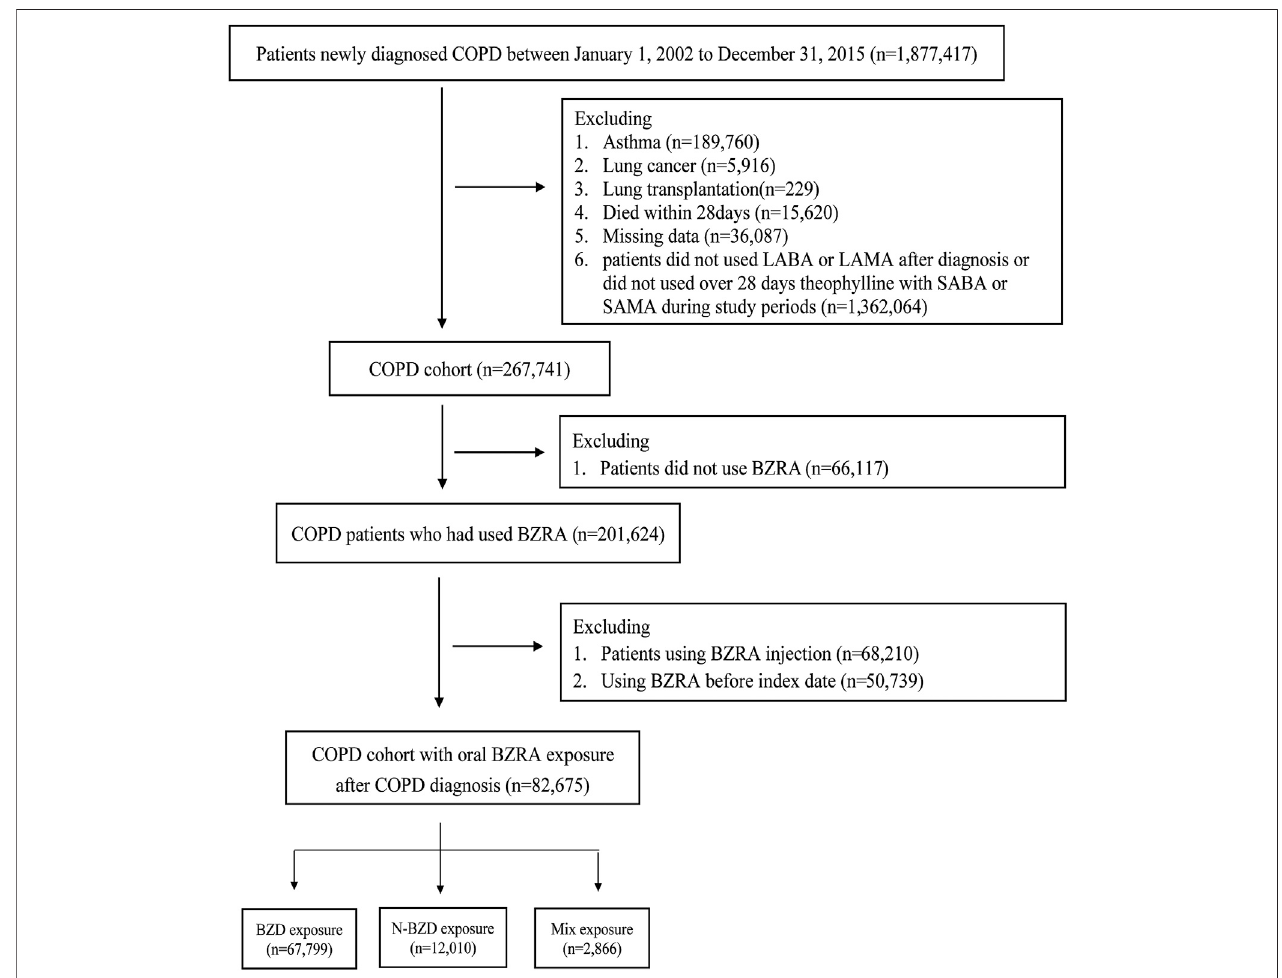
FIGURE 1 | Flow chart of the patients enrolled in the COPD